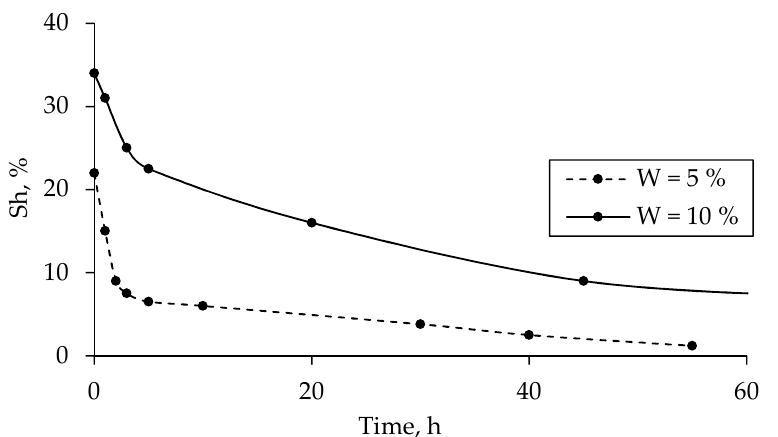
Figure 9. Time-dependent hydrate saturation in sand 1 samples with initial moisture contents of 5% and 10% after the pressure dropped to 0.1 MPa at − 6 ◦ C. Black dots are experimental data; the solid line is a trend line of exponential approximation.